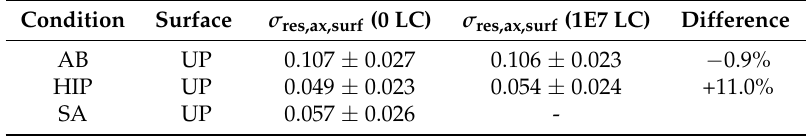
Table 3. Axial surface residual stress measurement results.